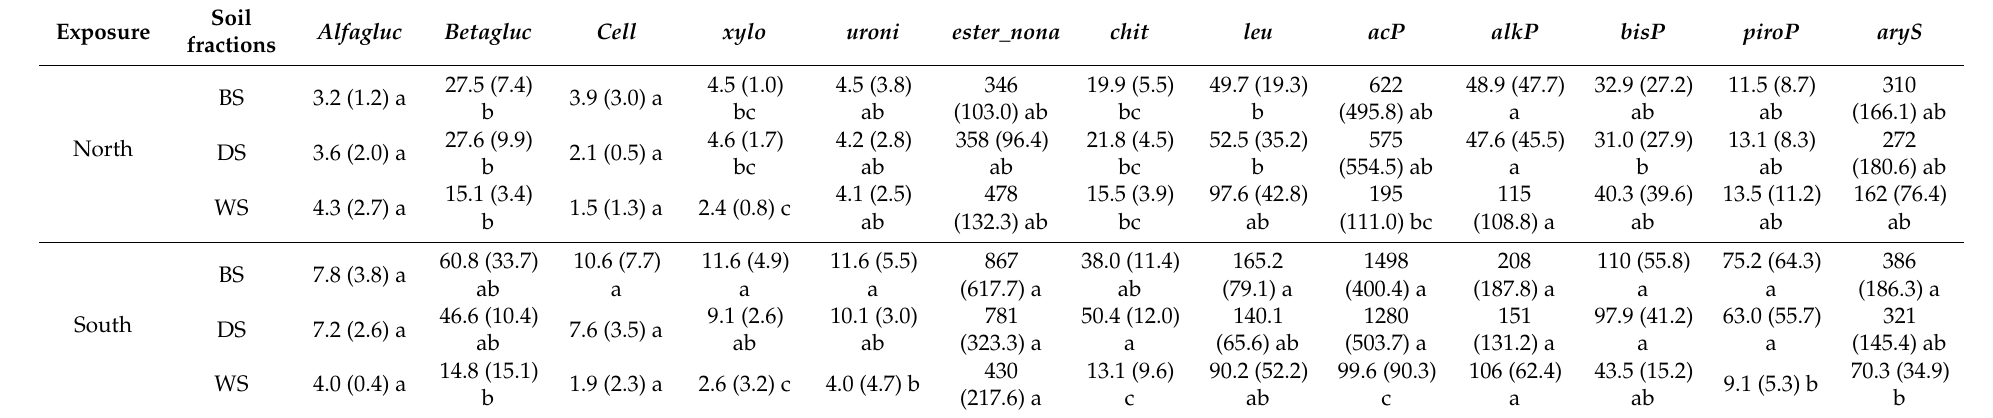
Table 5. Overview of the potential enzymatic activities observed in the bulk soil and the aggregate size fractions (dry-sieved and water-stable 1.00–0.50 mm) in the mineral (AE) horizon at the north- and the south-facing sites. Values are means ( n = 3) with the standard deviations in brackets. Data are expressed as nanomoles